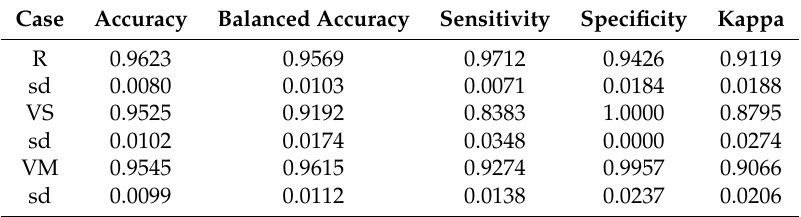
Table 6. Classification results using only the most relevant terms for each type of aggression. The results are shown averaged over 30 runs. Standard deviation (sd) is also